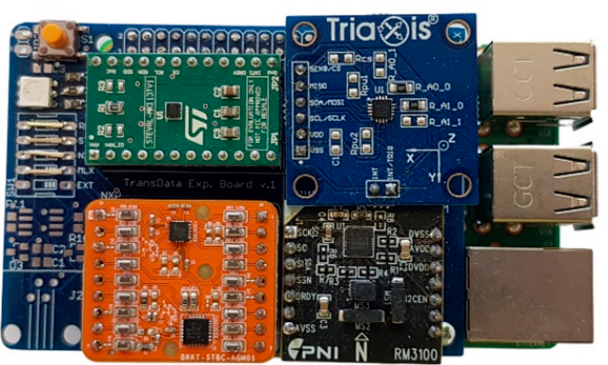
Figure 2. Completed measurement board with all magnetometer break-out boards installed in the top and Bluetooth module installed in the bottom (all attached to the developed shield).